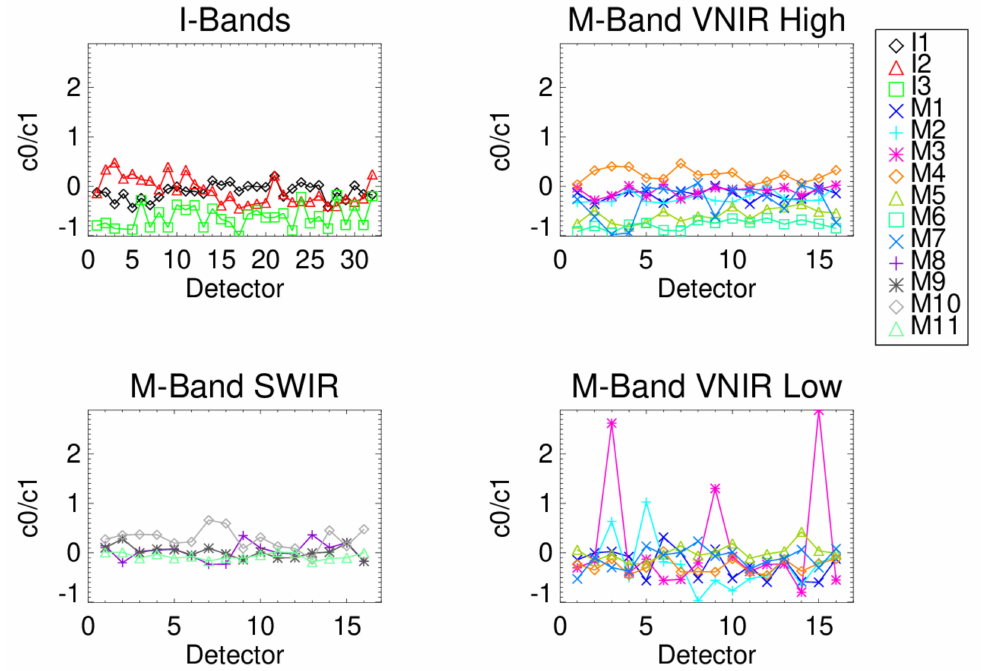
Figure 12. Comparison of the c 0 coefficient for all RSBs at nominal TVAC plateau. The upper left c 1 are the I-bands, upper right high gain VNIR M-bands, lower left the SWIR M-bands, and the lower right, the low gain VNIR M-bands. The x-axis is detector, and the colors/symbols correspond to a particular